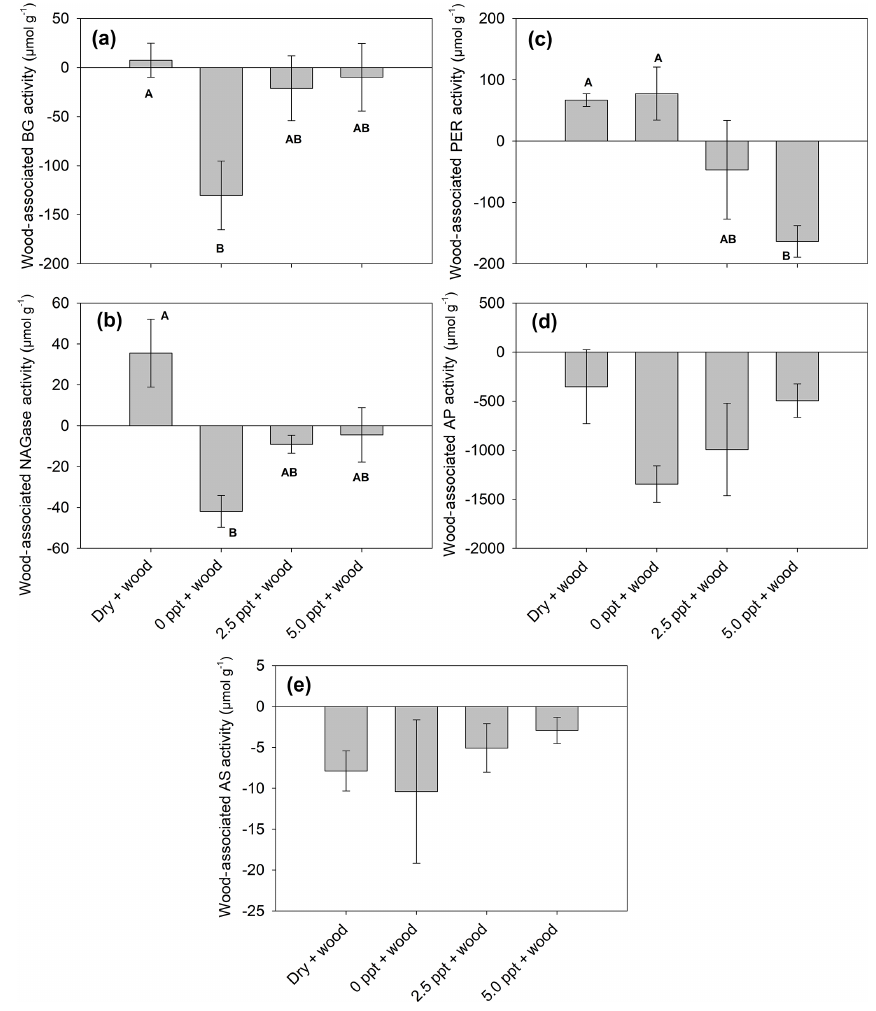
Figure 6. Wood-associated (wood-amended – wood-free) enzyme activity (BG: β -glucosidase; PER: peroxidase; NAGase: glucosaminidase; AP: alkaline phosphatase; and AS: arylsulfatase). Bars represent the mean with standard error ( n = 4). Treatment means with different upper letters are significantly different ( P < 0 .